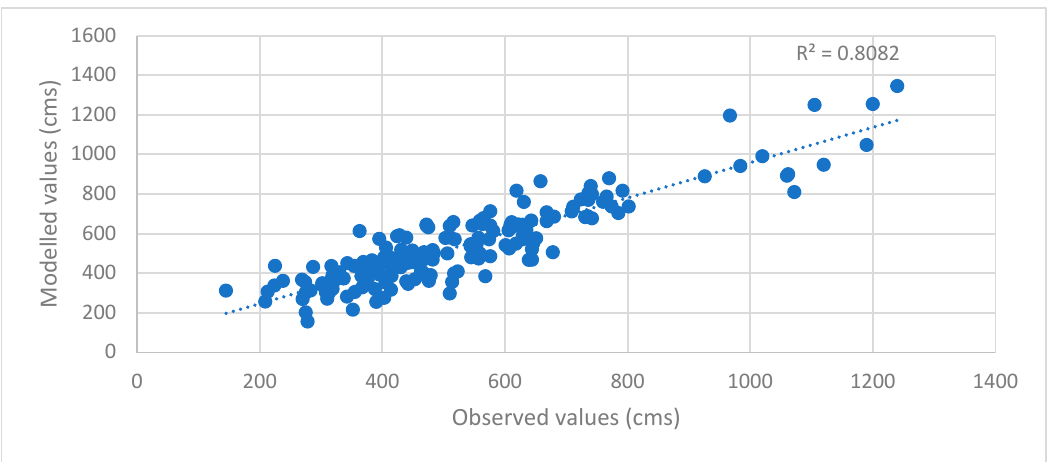
Figure A5. Correlation graph for gauge station “[Below] Kapchagay” with the R 2 value.